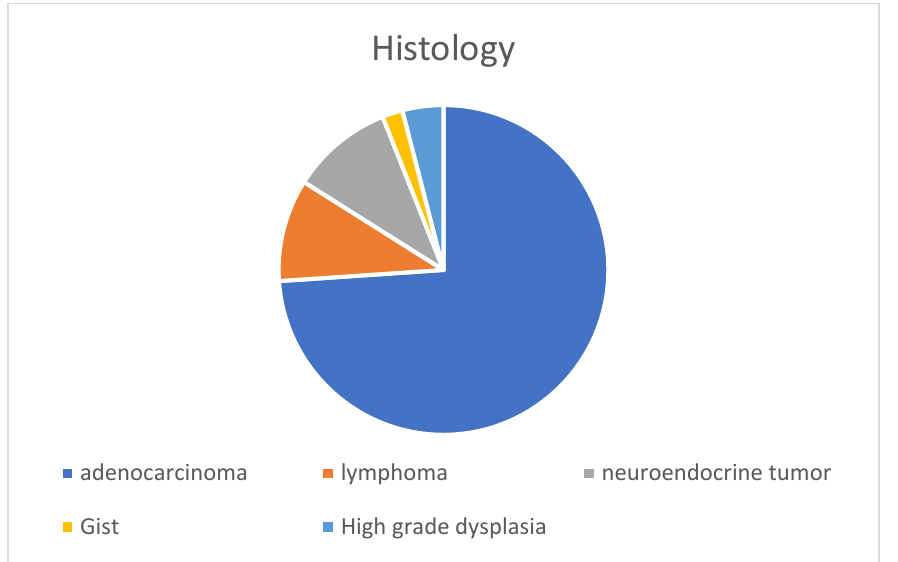
Figure 2. Histology of small bowel neoplasia.